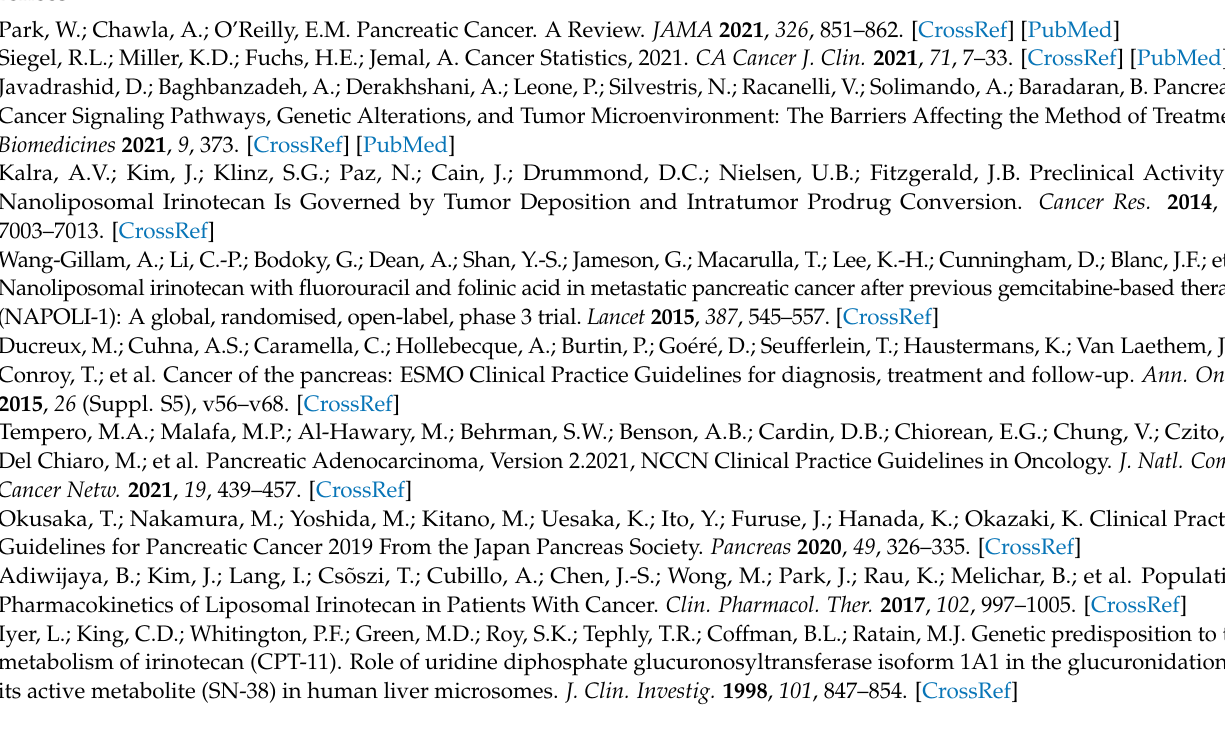
Table S2. Treatment details for all patients, Table S3. Treatment details for patients with UGT1A1 double variants, Table S4. Adverse events for patients with UGT1A1 double variants, Figure S1. Progression-free survival (A) and overall survival (B) in patients with UGT1A1*1/*6 and in those with UGT1A1*1/*28, Figure S2. Progression-free survival (A) and overall survival (B) of patients with UGT1A1 double